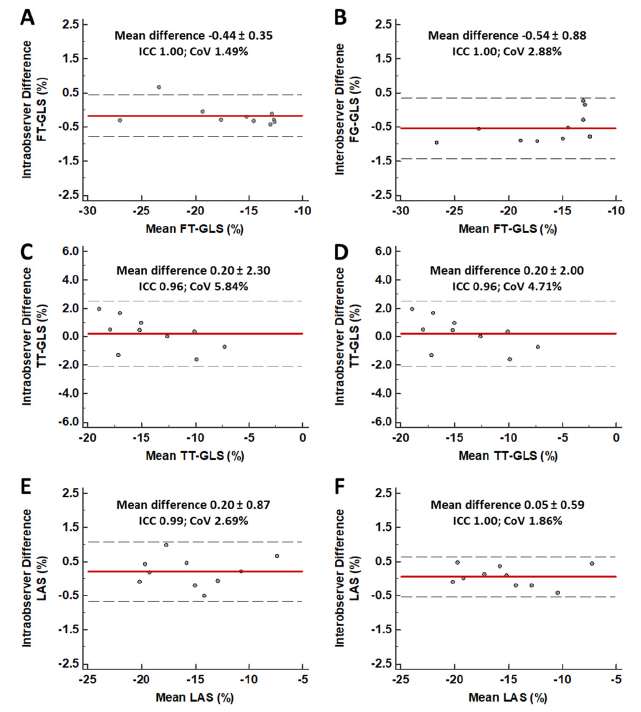
Figure 2. Intra- and Inter-observer variability of di ff erent approaches for strain assessment. Bland–Altman analysis showing low intra- and inter-observer variability for FT-GLS (Panels A and B ), TT-GLS (Panels C and D ), and fast manual LAS (Panes E and F ). Red line = mean absolute di ff erence; Black, dotted lines = 95% confidence interval. CoV = Coe ffi cient of variation; FT = feature tracking; GLS = global longitudinal strain; ICC = Intraclass correlation coe ffi cient; LAS = long-axis strain; TT = tissue tracking.